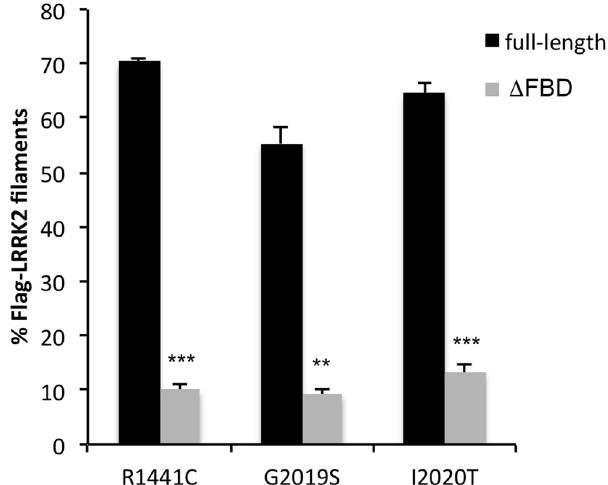
Figure 8. Quantification of LRRK2 recruitment to FADD DEFs. The percentage of LRRK2 filamentous structures co-localized with FADD DEFs was determined in a blinded fashion for each pair of full-length or deletion mutant LRRK2 constructs: R1441C, G2019S, and I2020T. ** p < 0.01 compared to full-length mutant LRRK2; *** p, 0.001 compared to full-length mutant LRRK2. Each data point represents the mean + / − SEM from 3–4 independent